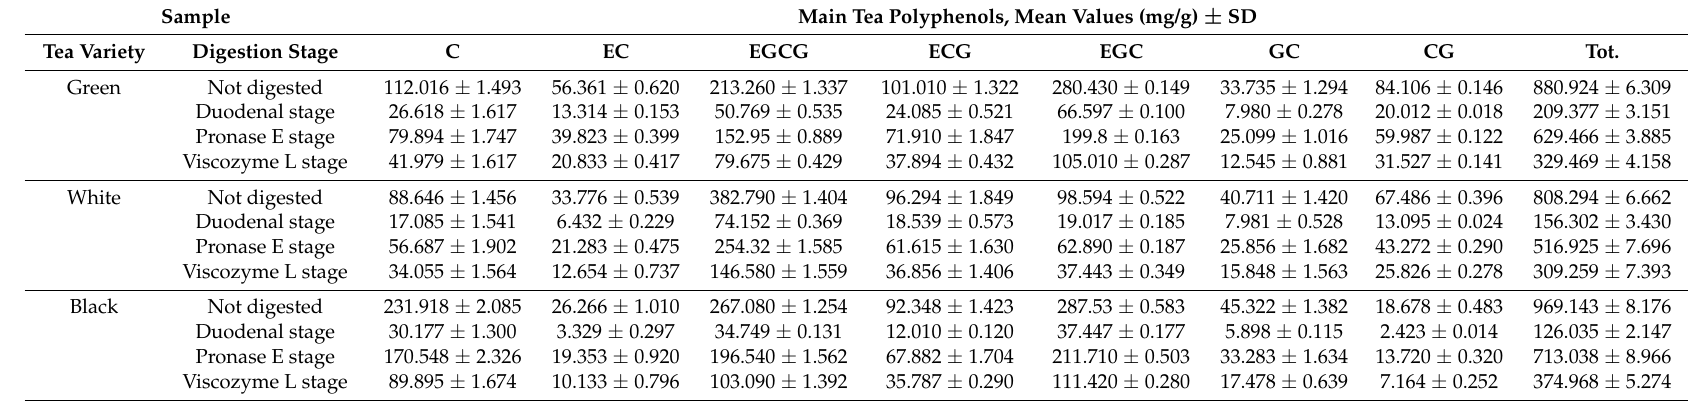
Table 2. HPLC-DAD analysis of the main tea